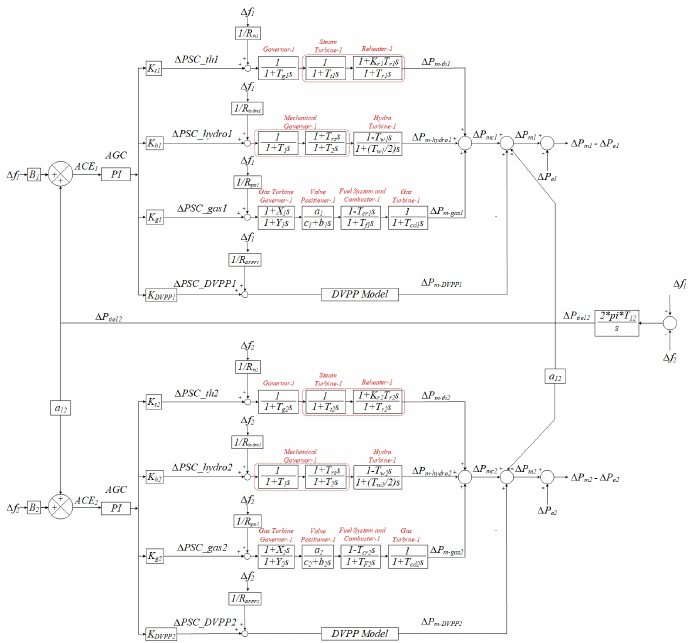
Figure 9. New control model for direct participation of the DVPP to a two-area